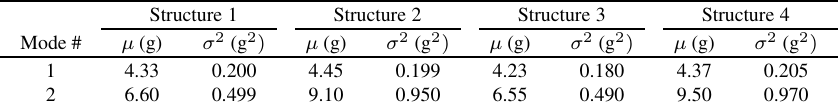
Table 3 Parameters for generation of base accelerations used in Monte Carlo analysis of two DOF structures Structure 1 Structure 2 Structure